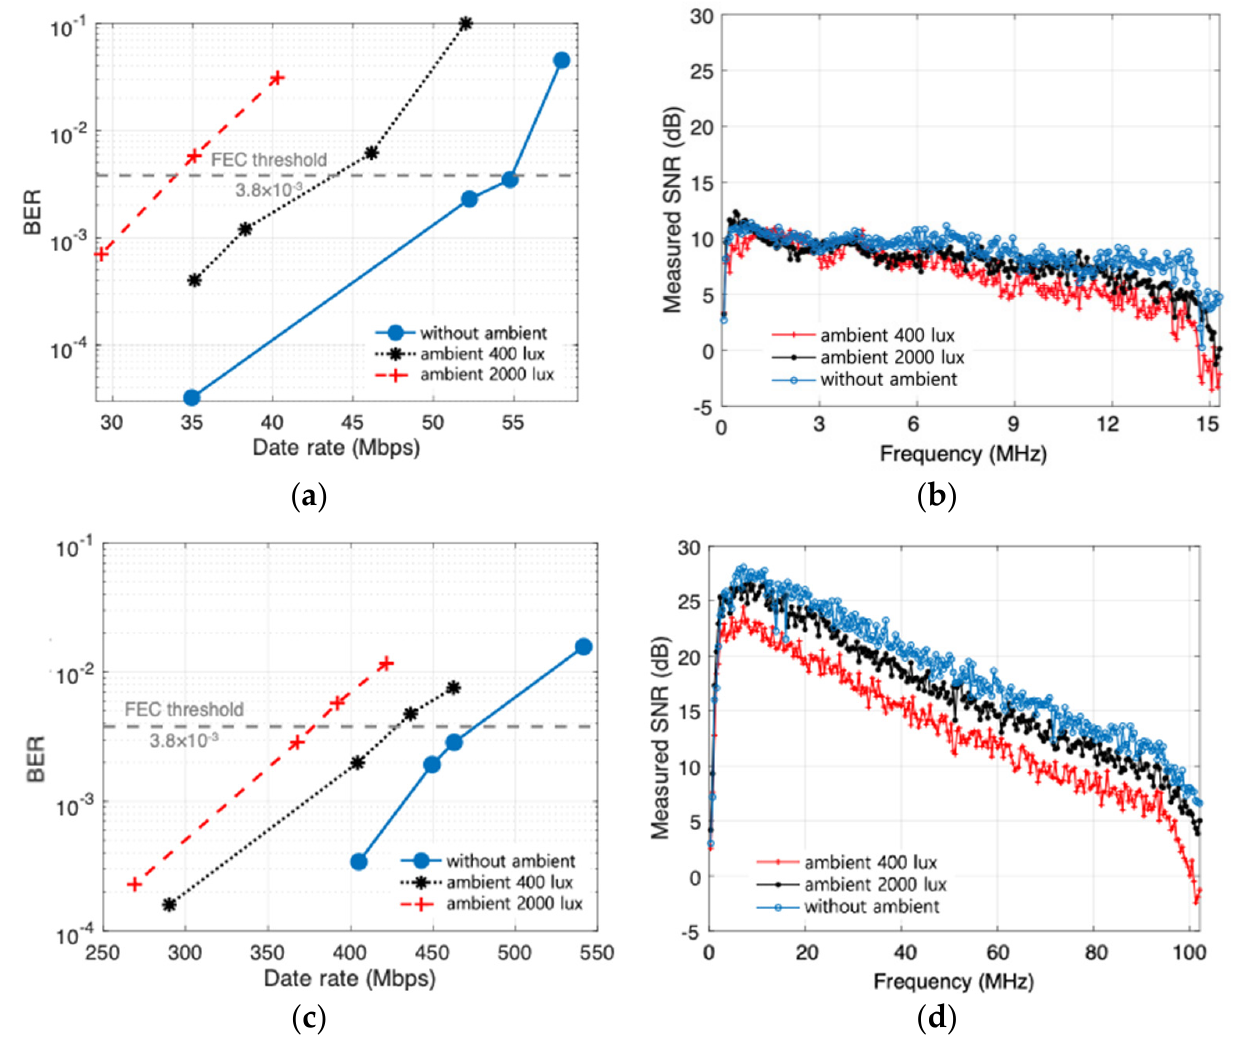
Figure 9. BER performance under ambient light for ( a ) headlamp at 100 lux and ( b ) measured SNR, and ( c ) BER performance under ambient light for blue LD beam at 0.08 W/m 2 and ( d ) measured SNR.